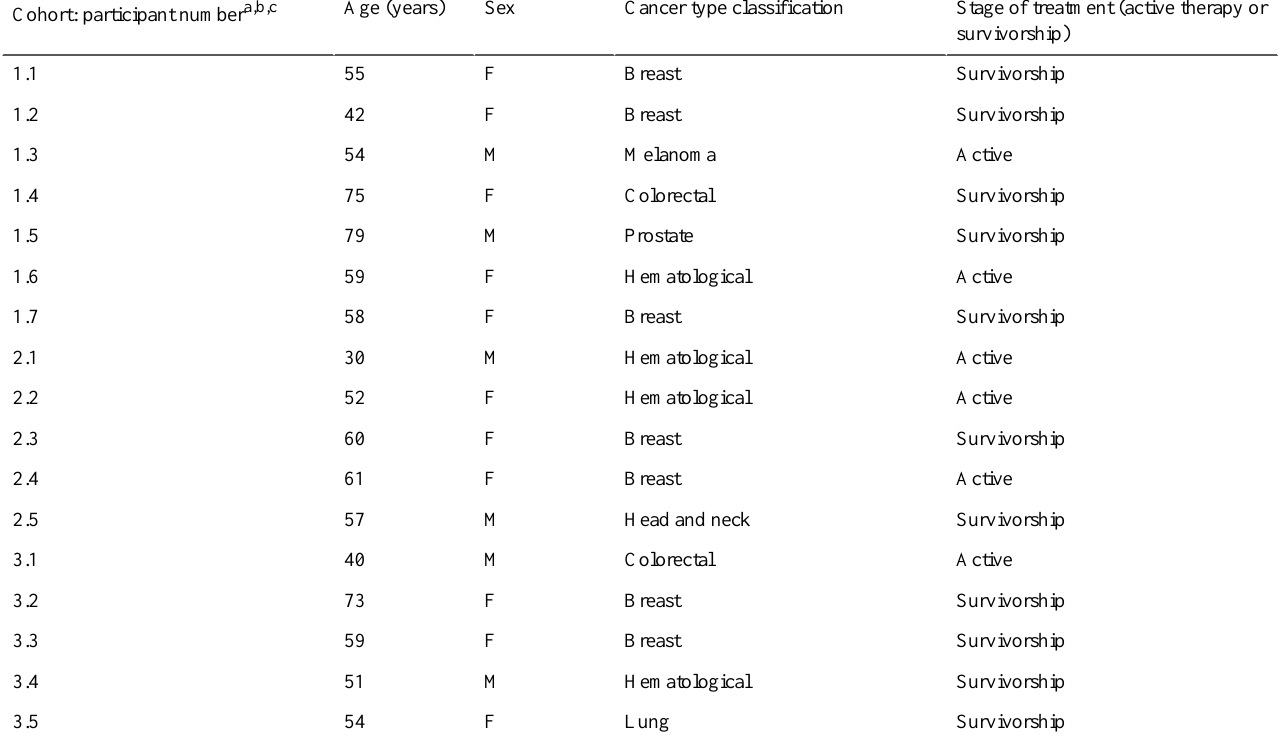
Table 1. Individual interviewee